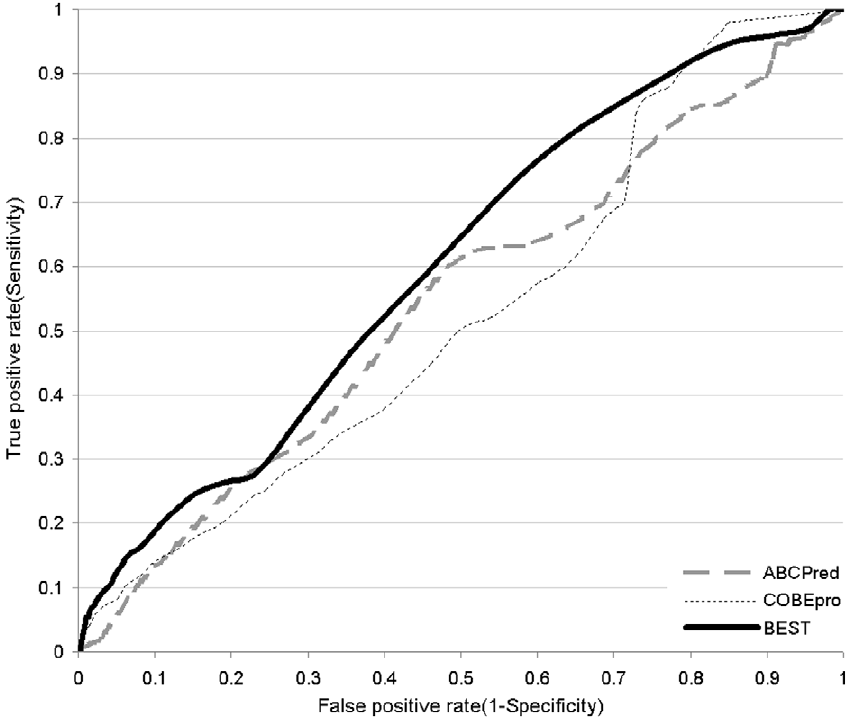
Figure 7. Receiver operating characteristic (ROC) curves of the considered B-cell epitope predictors on the SEQ19 dataset.